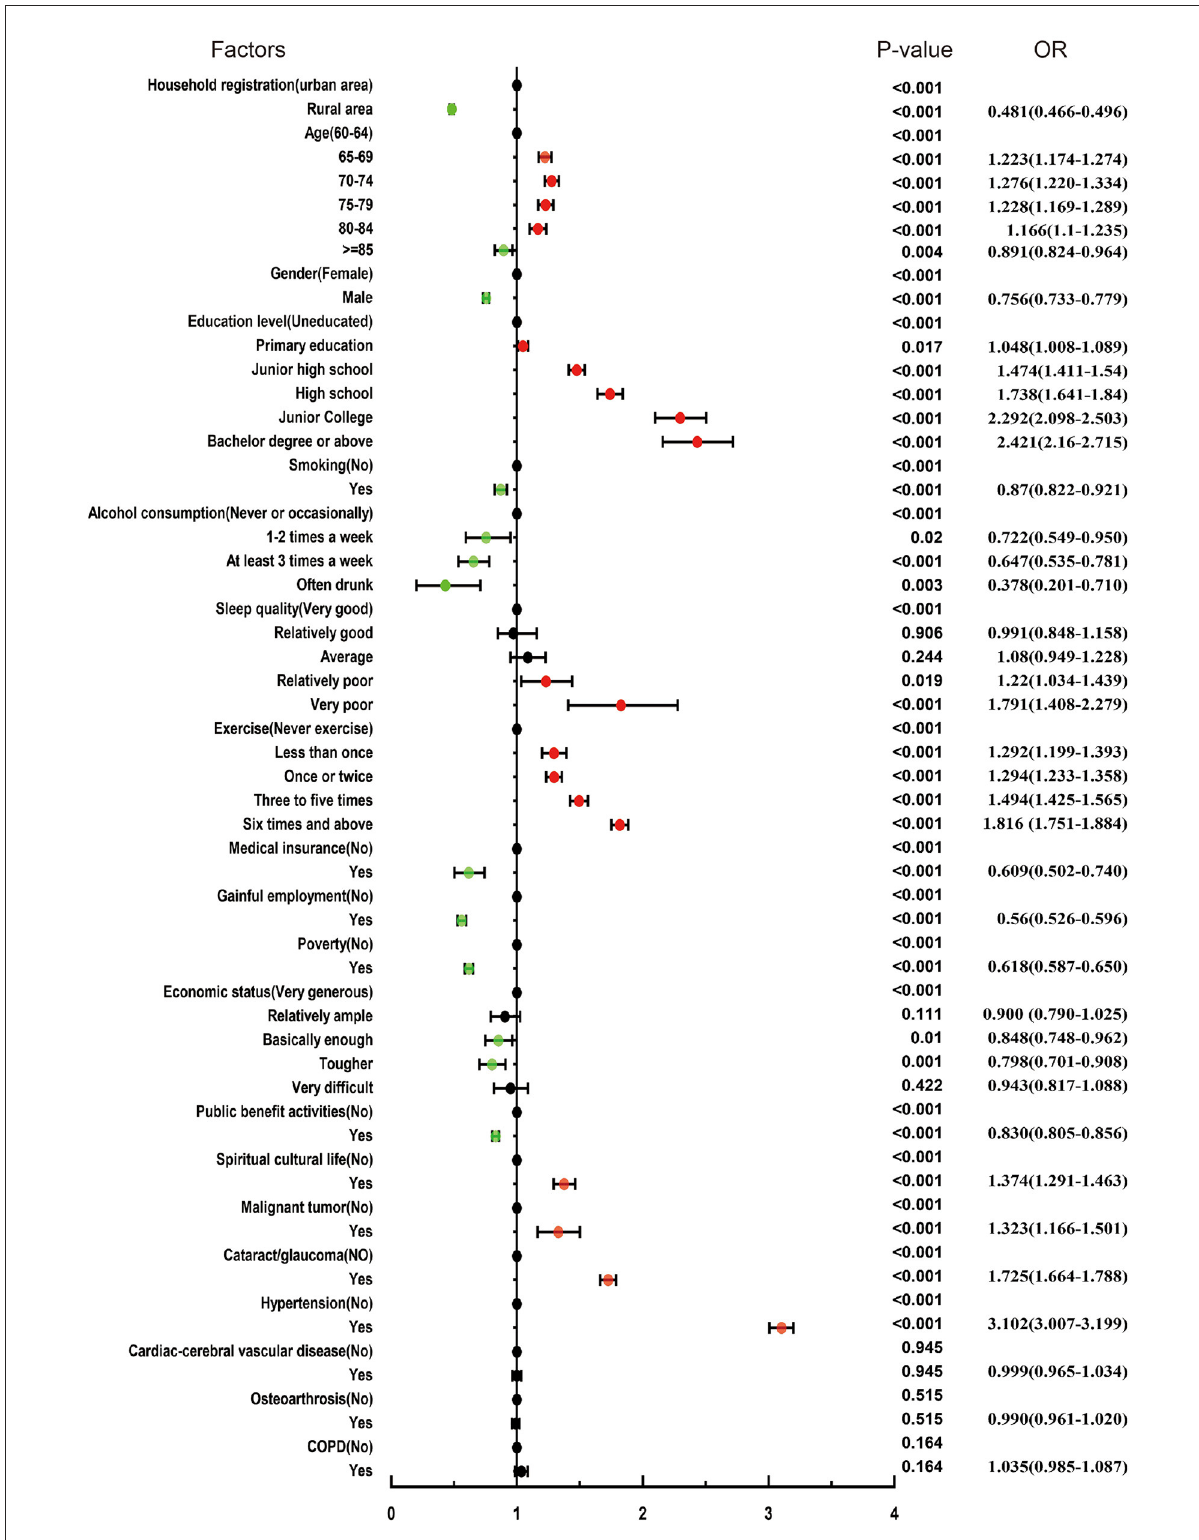
FIGURE3 Association between related factors and diabetes by univariable logistic regression